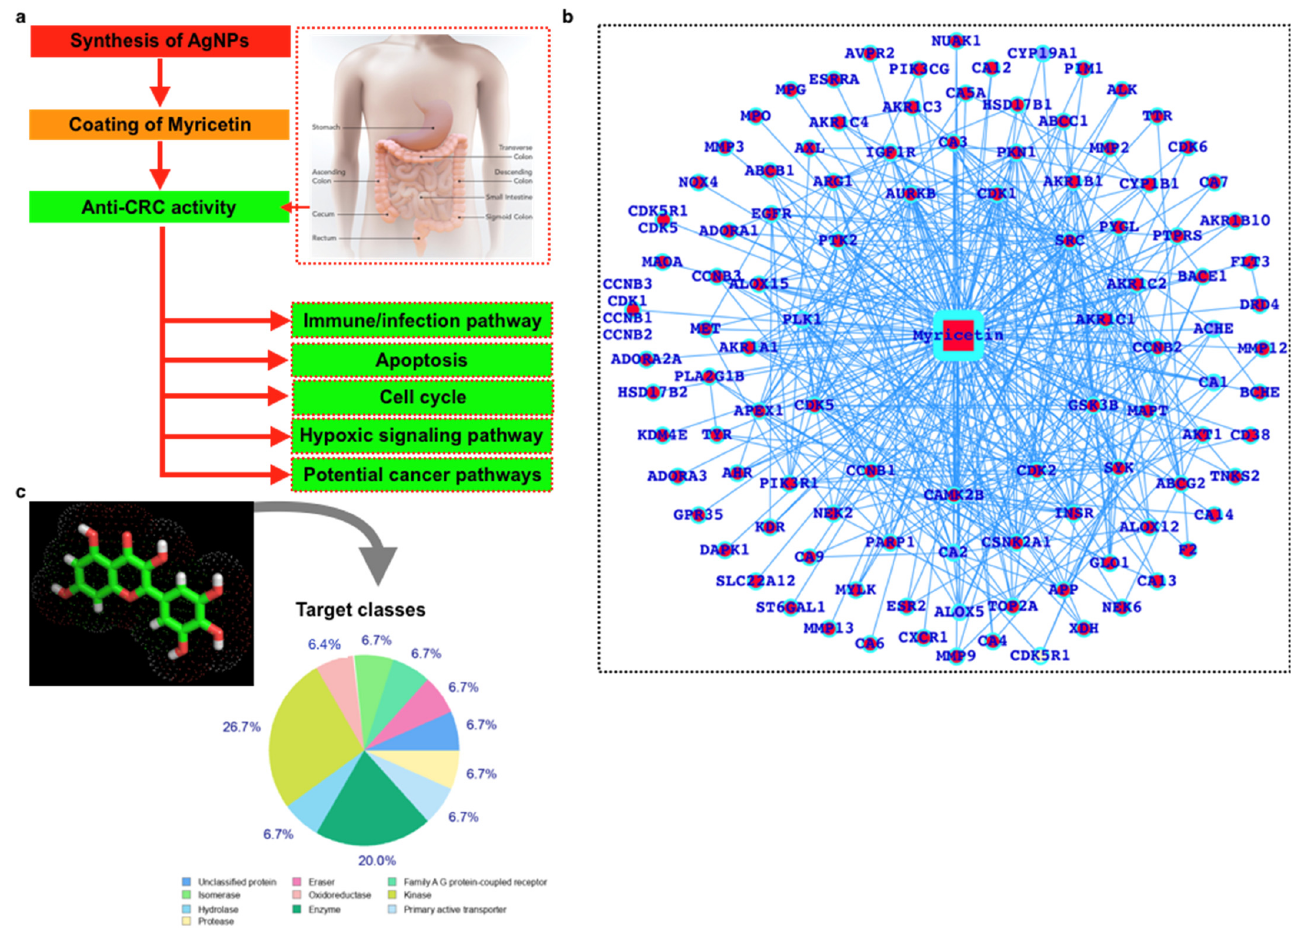
Figure 1. ( a ) Workflow, ( b ) myricetin interactors, and ( c ) the panther classes of the interactors.